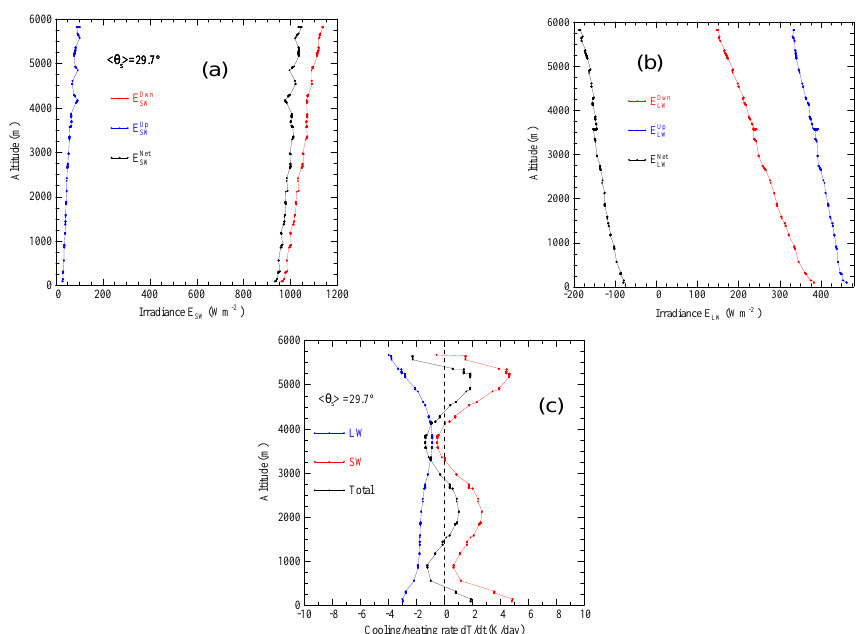
Figure 28. SW (a) and LW (b) upward and downward radiative fluxes observed over the Lampedusa station for 22 June and estimated SW and LW heating rate (c) in the two spectral regions (see Sect. 5.4.4 for details).